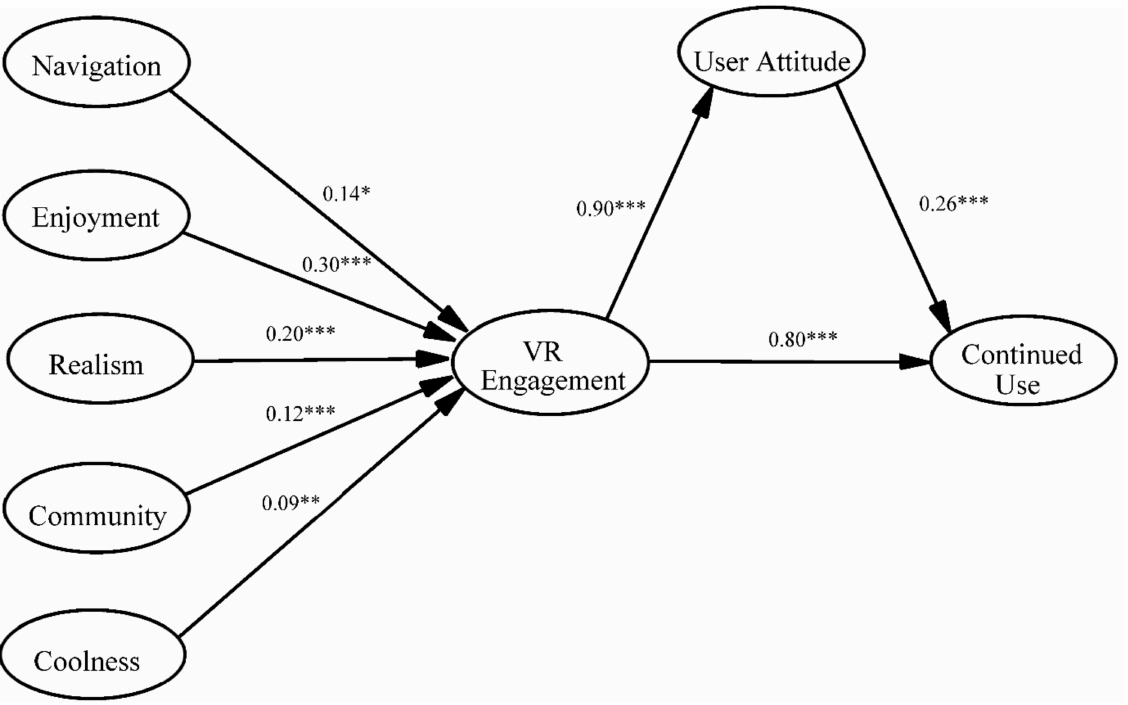
Figure 2. The results of the structural equation model. Note: *** p < 0.001; ** p < 0.01; * p <